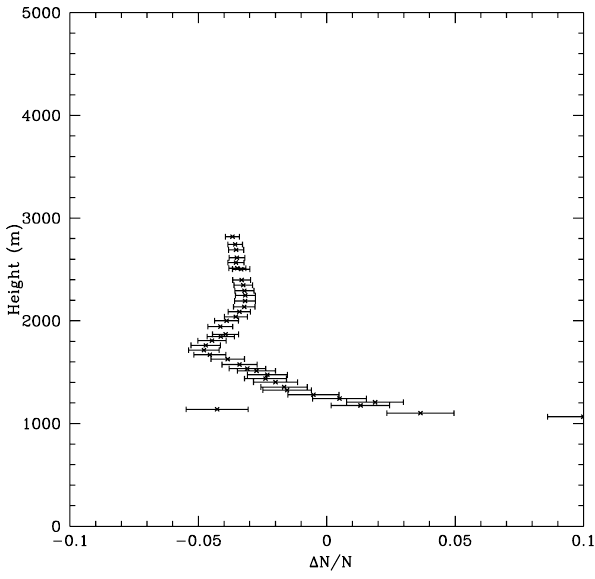
Fig. 7. Refractivity correction coefficients ( 1N profile. A multidimensional solution space has provided this solu- tion. It allows a serie of independant layers with different refractiv- ity index